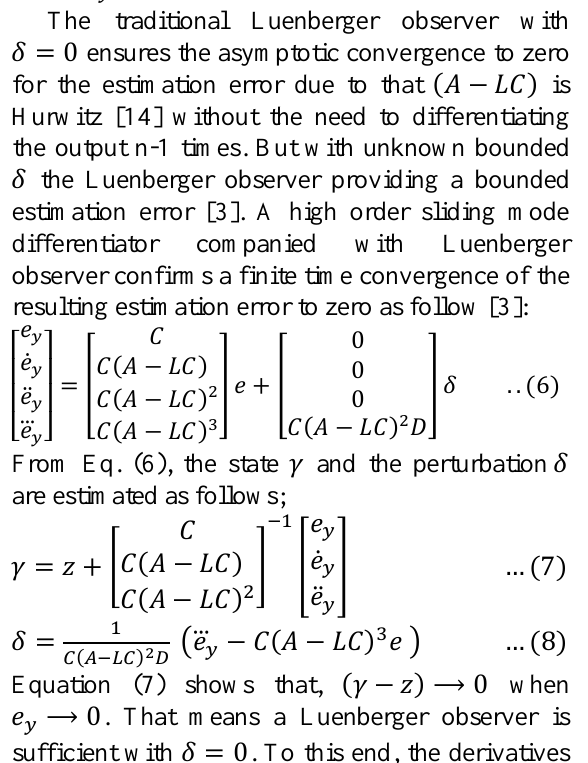
Fig. 1. Control design